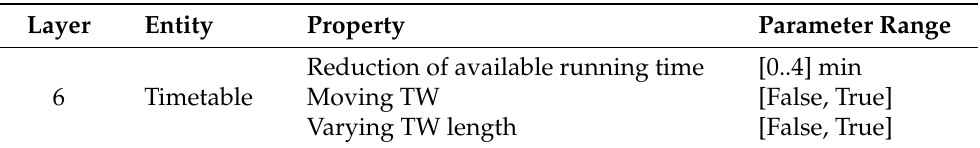
Reduction of available running time [0..6] min Table 5. Description of the entities and their parameters relevant for testing the influence of different timetables and the variation of TWs of CTPs on the ATO performance. Only showing relevant definitions differing from the base